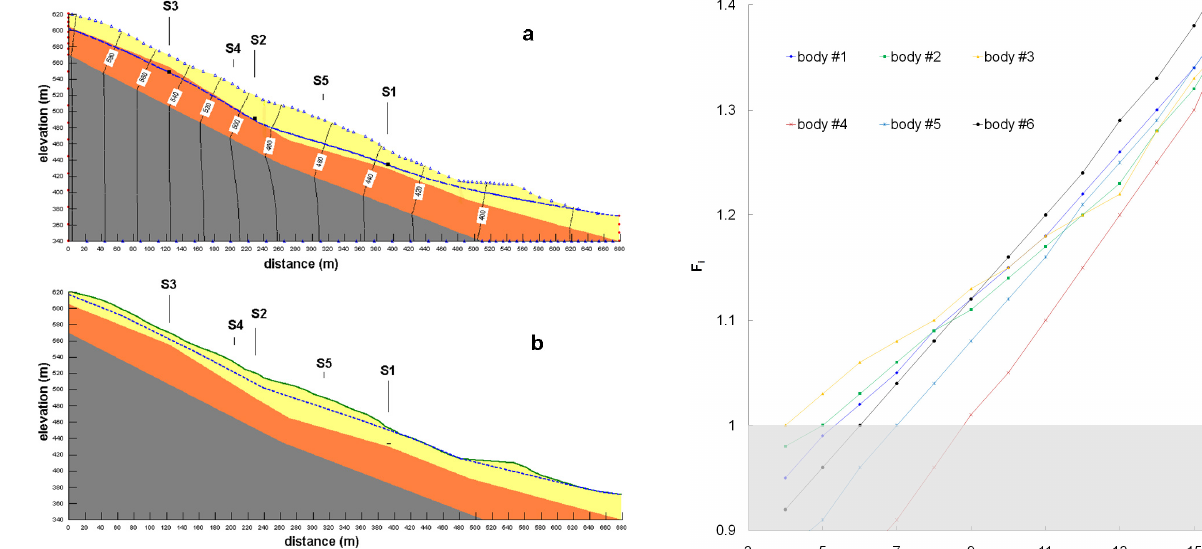
Fig. 10. San Rocco landslide: equipotential lines and water table surface calculated for steady-state seepage regime (a) , and max- imum raising of water table considered in the parametric analy- ses (b) .